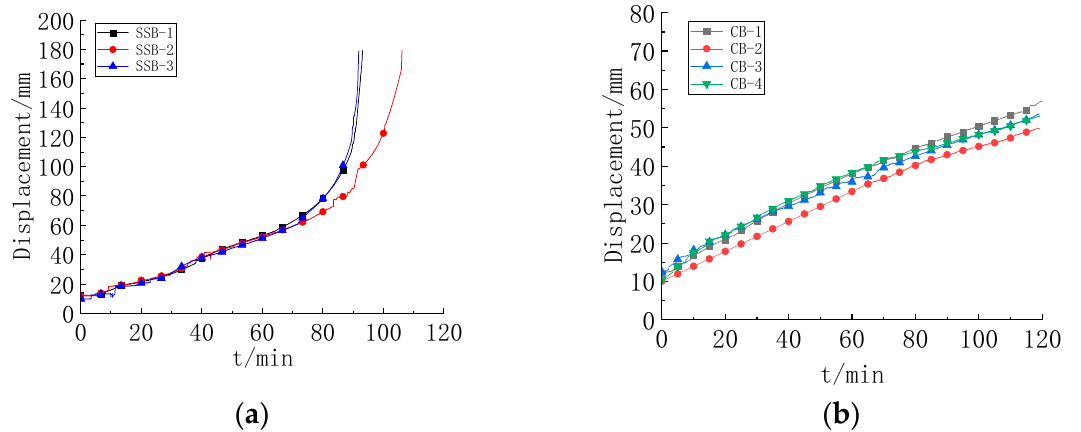
Figure 14. Increase in mid-span displacement with time for specimens exposed to fire: ( a ) SSB; ( b ) CB .